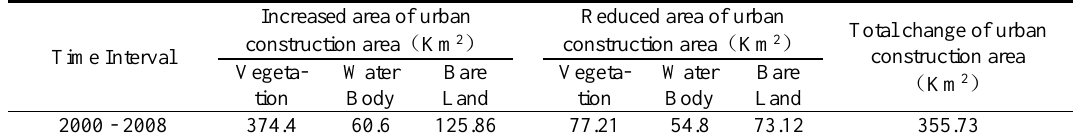
Table10 Urban construction area change from the year 2000 to